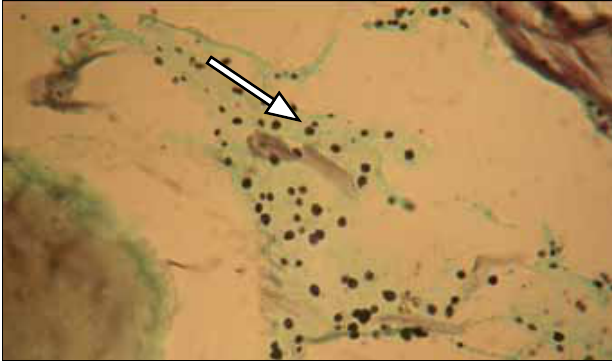
Fig 9. Silver stain demonstrating yeast cells with faint